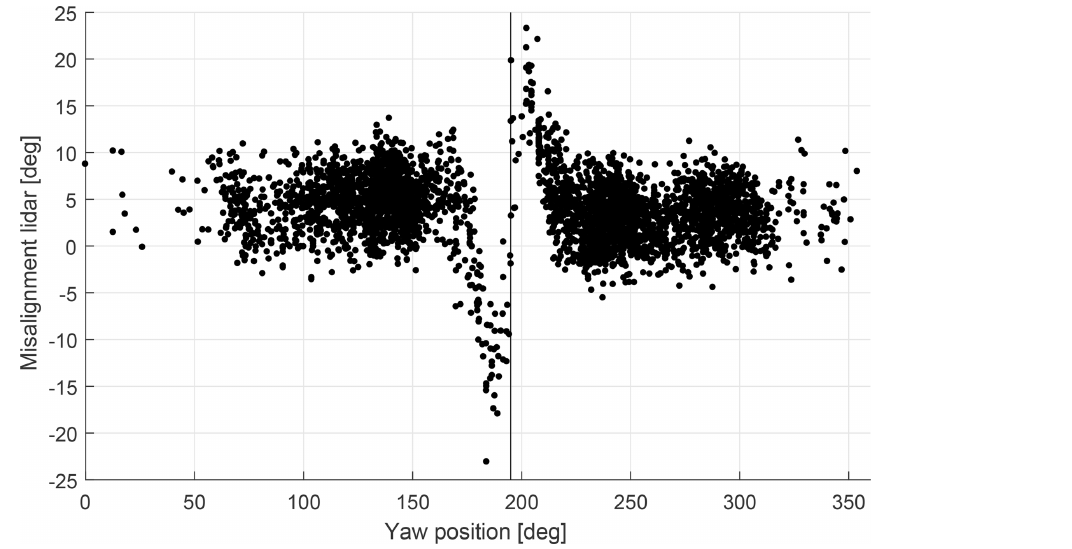
Figure 5. Lidar-estimated 10min mean yaw misalignment b φ as function of turbine yaw position. The vertical black line indicates the position of the upstream Nordtank turbine. A clear influence of the wake on the misalignment estimates around the wake sector can be seen.